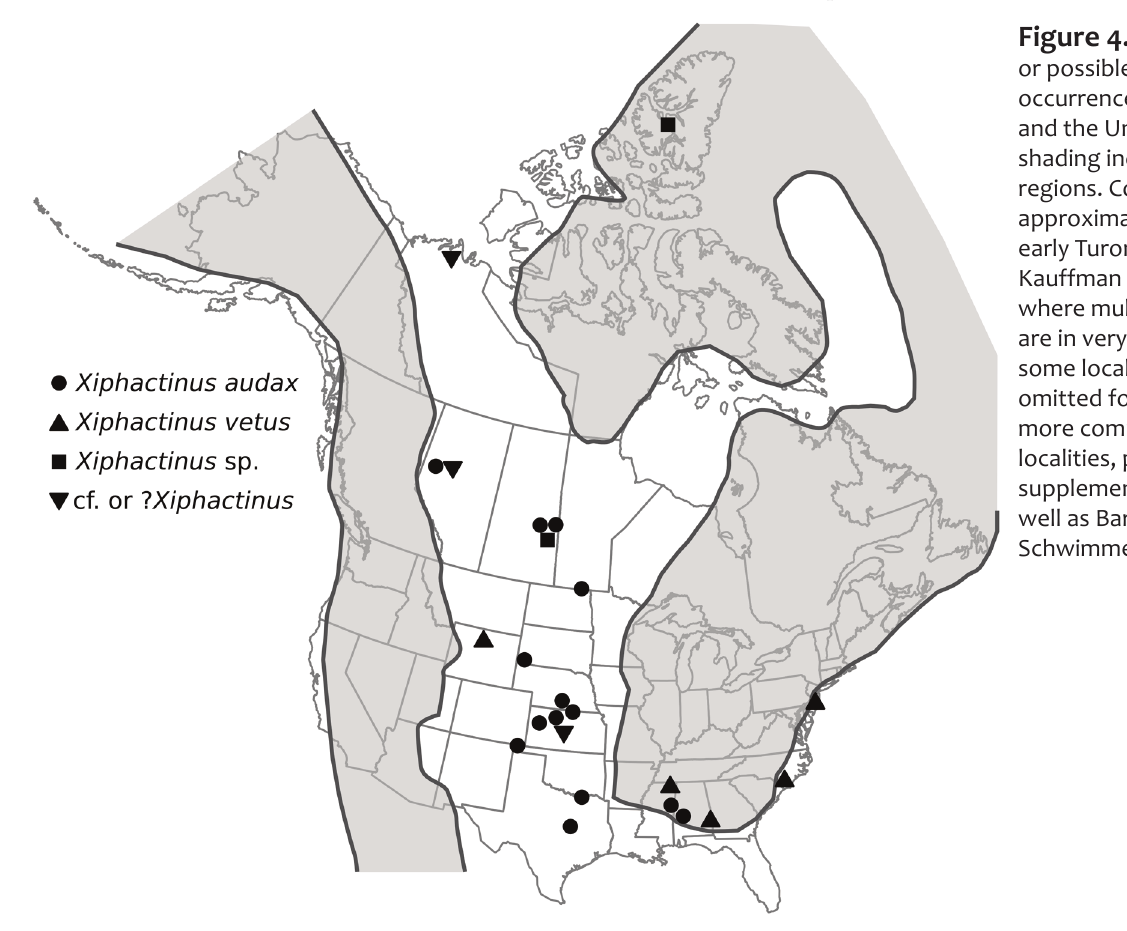
Figure 4. Map of confirmed or possible Xiphactinus occurrences from Canada and the United States. Grey shading indicates non-marine regions. Coastline shown is approximately that of the early Turonian, adapted from Kauffman (1984). In cases where multiple localities are in very close proximity, some localities have been omitted for clarity. For a more comprehensive list of localities, please consult the supplementary materials, as well as Bardack (1965) and Schwimmer et al.